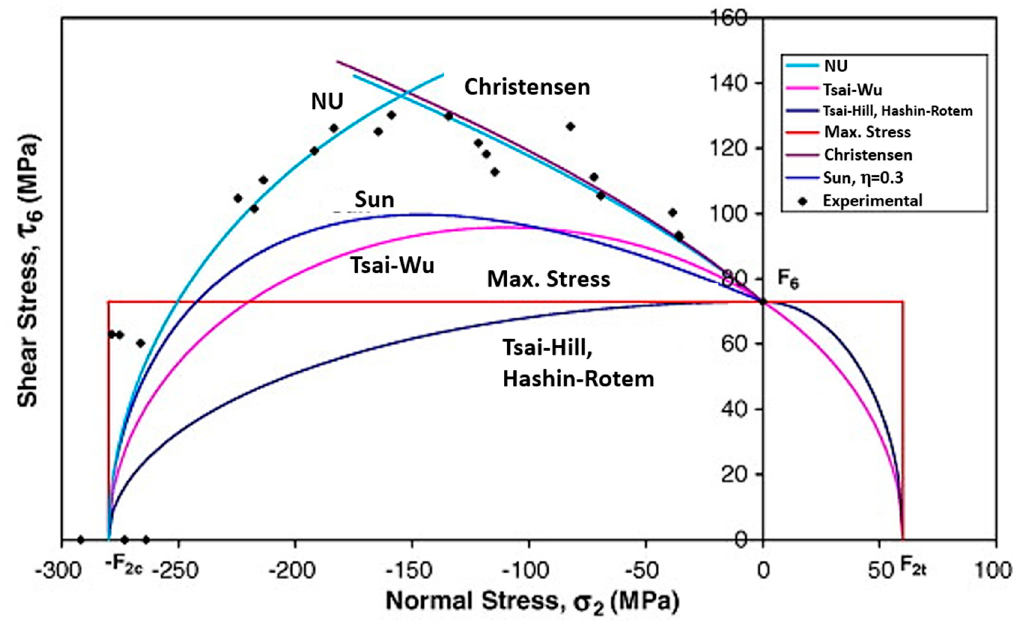
Figure 14 . Comparison of theoretical and experimental results. Reproduced with permission [191]. Polymers 2020 , 12 , 818